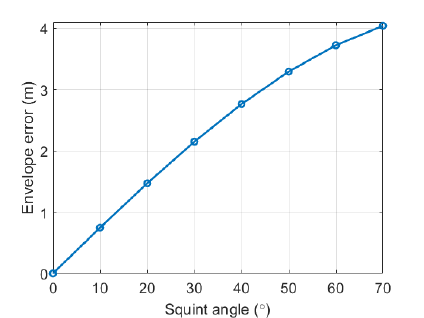
Figure 7. Channel errors versus squint angles.